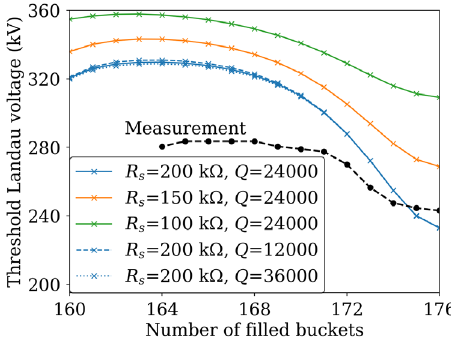
FIG. 7. Threshold Landau-cavity voltage for different fill patterns in the MAX IV 3 GeV as calculated for different HOM shunt impedances and quality factors. The measured curve is also included for reference.